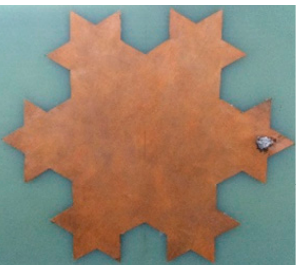
Figure 10. Physical map of the designed antenna.